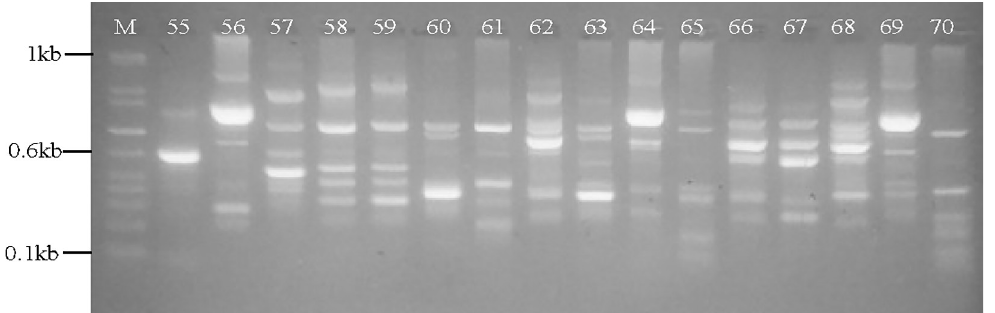
Fig 1. Representative example of ERIC fingerprints of different carbapenem-resistant isolates on agarose gel electrophoresis. Note: M = DNA 1 kb marker, 55 through to 70 = numbered fingerprints. By visual inspection sample numbers 58 & 59 are showing close relatedness on the